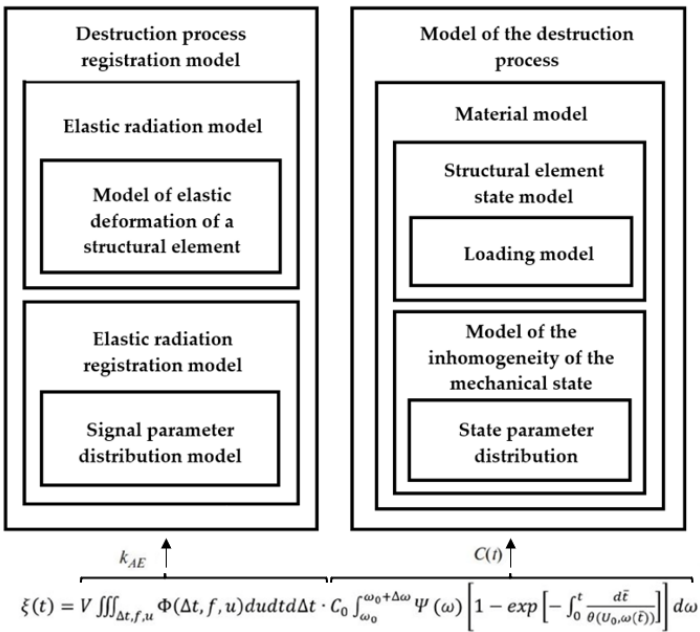
Figure 4. Block diagram of a multilevel model of acoustic emission pulse flow.